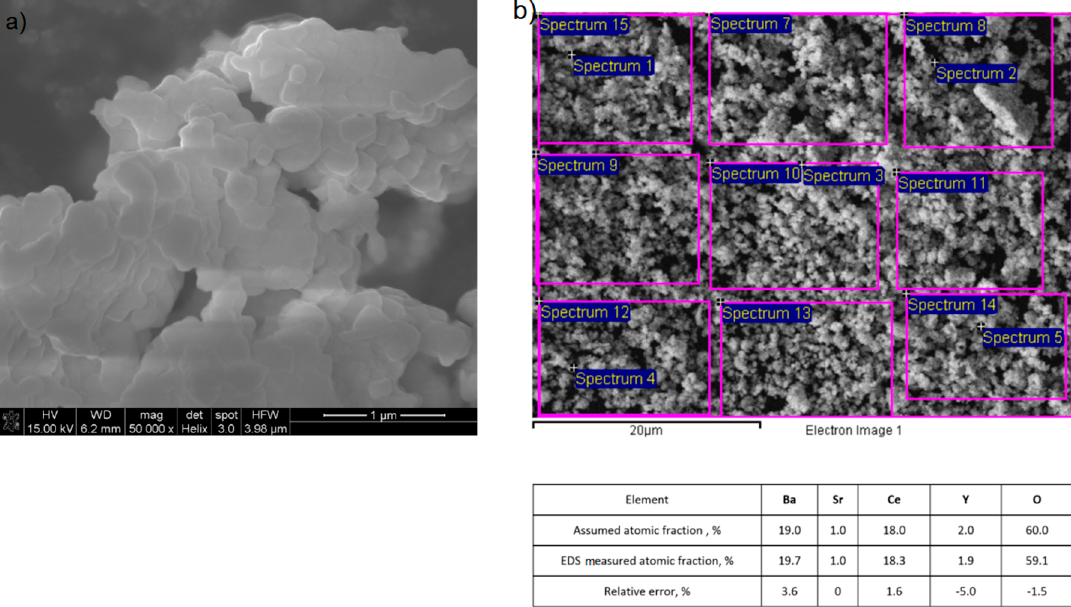
Figure 5. The representative SEM image recorded for 5SBCY powder ( a ) and SEM / EDS chemical analysis ( b ) performed for this sample.